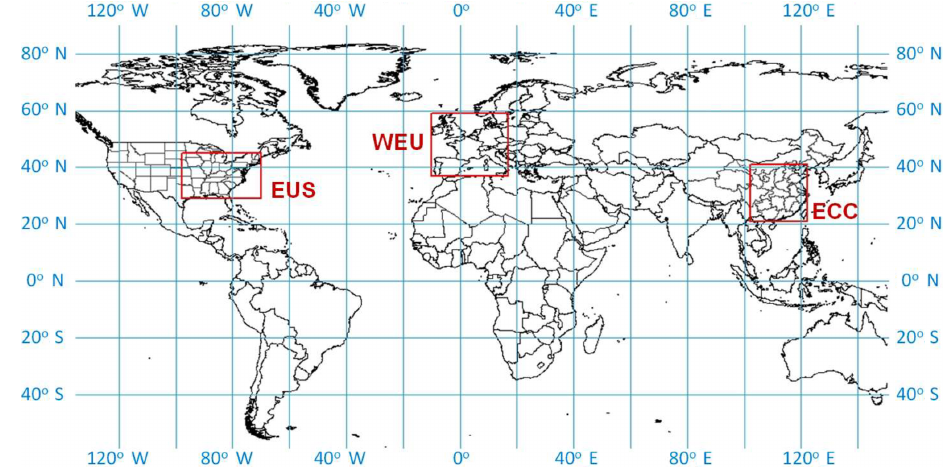
Figure 1. Target regions for this study: the Eastern United States (EUS), Western Europe (WEU), and Eastern and Central China (ECC).